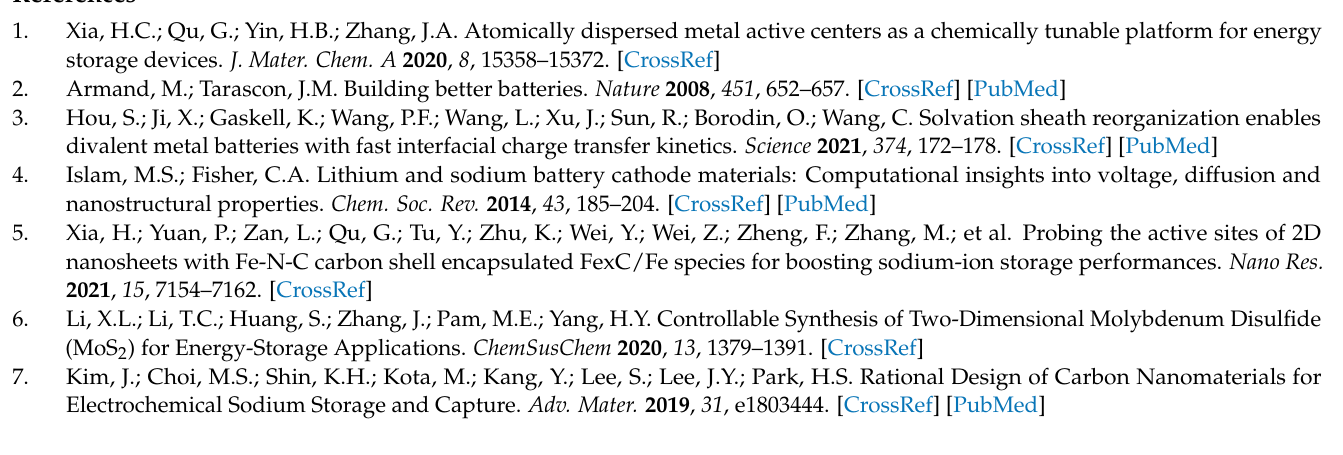
Figure S3: (a) CV curves at various scan rates of MoS 2 . (b–f) Capacitive-controlled and diffusion- controlled contributions at different scan rates of MoS 2 ; Figure S4: (a–d) Capacitive-controlled and diffusion-controlled contributions at different scan rates of MoS 2 /C; Figure S5: Morphology and nanostructure characterizations of MoS 2 electrode after 600 long-term cycles under the current den- sity of 2.0 A g − 1 ; Figure S6: Morphology and nanostructure characterizations of MoS 2 /C electrode after 600 long-term cycles under the current density of 2.0 A g − 1 ; Figure S7: (a) XPS full spectra and high-resolution (b) C 1s, (c) Mo 3d, and (d) M S 2p spectra of MoS 2 /C after long-term cycles; Table S1: Comparison of the rate and cycle performance between MoS 2 /C NFs with the recently re- ported MoS 2 -based anode materials. Ref [18,23,25,30,39,40] are cited in the supplementary